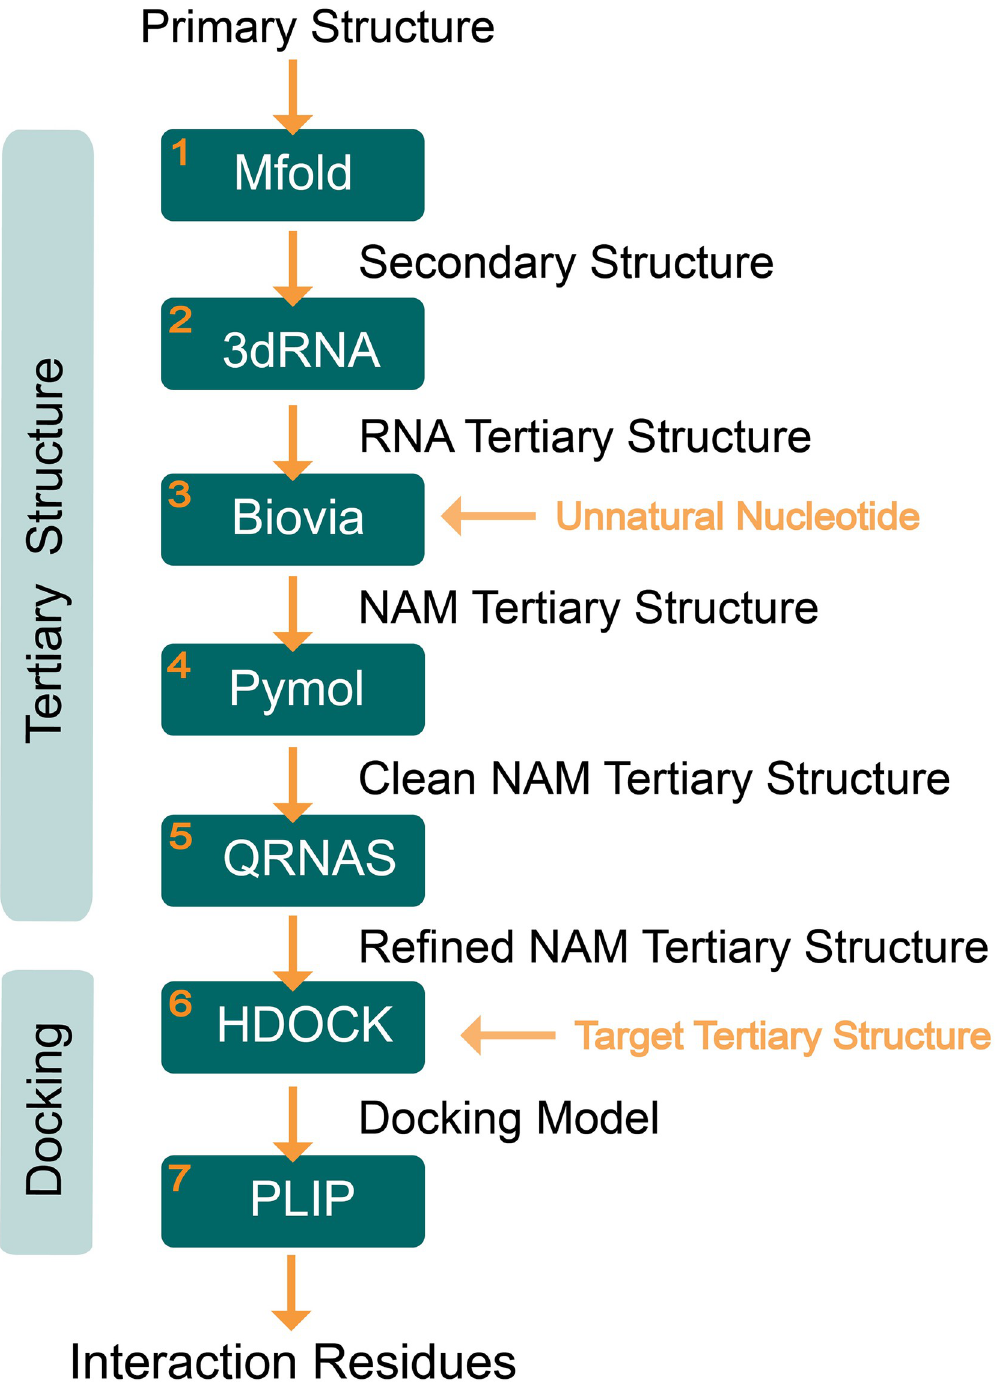
Fig 1. Workflow to predict the tertiary structure of NAM aptamers (using the aptamers sequence as a starting point) and the docking model (including the identification of nucleotides that interact with the target molecule). The yellow horizontal arrows are additional inputs necessary to run the